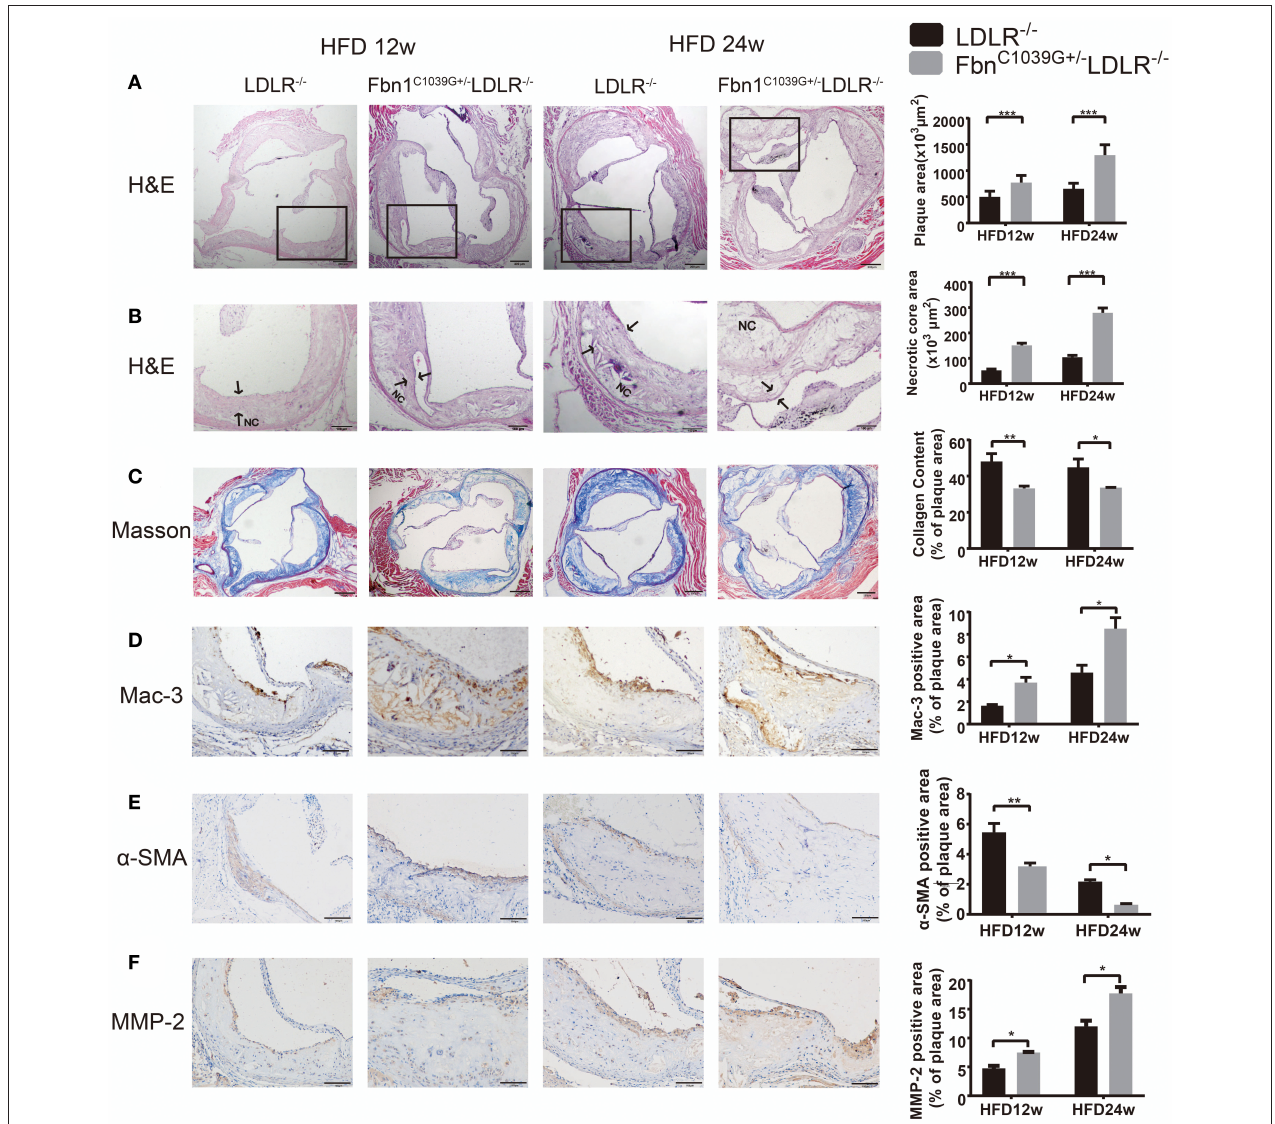
FIGURE 4 | Plaque characteristics of Fbn1 C1039G + / − LDLR − / − and LDLR − / − mice after 12 or 24 weeks on a HFD. (A) H and E staining of the aortic sinus of Fbn1 C1039G + / − LDLR − / − and LDLR − / − mice after 12 and 24 weeks on a HFD ( n = 9). (B) Partial enlargement of (A) showing the necrotic cores ( n = 9). (C) Masson staining of the aortic sinus of the two groups of mice after 12 and 24 weeks on a HFD ( n = 6). (D) Mac-3 staining of the aortic sinus of Fbn1 C1039G + / − LDLR − / − and LDLR − / − mice after 12 and 24 weeks on a HFD ( n = 4). (E) α -SMA staining of the aortic sinus of Fbn1 C1039G + / − LDLR − / − and LDLR − / − mice after 12 and 24